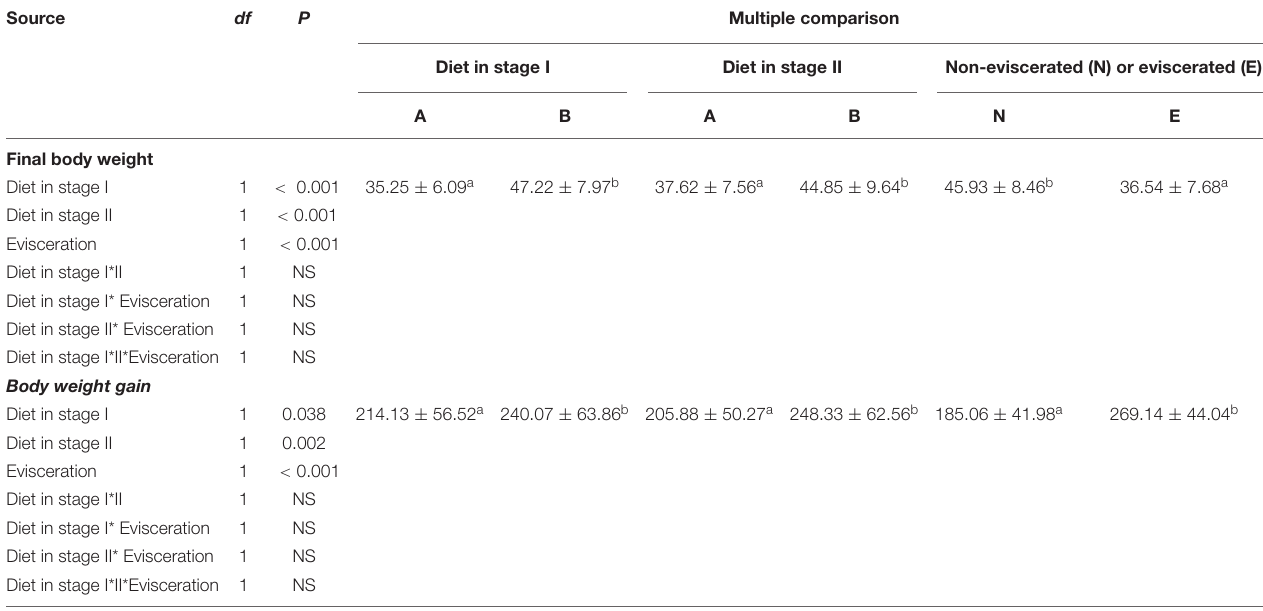
TABLE 3 | The growth performance of A. japonicus in stage II.